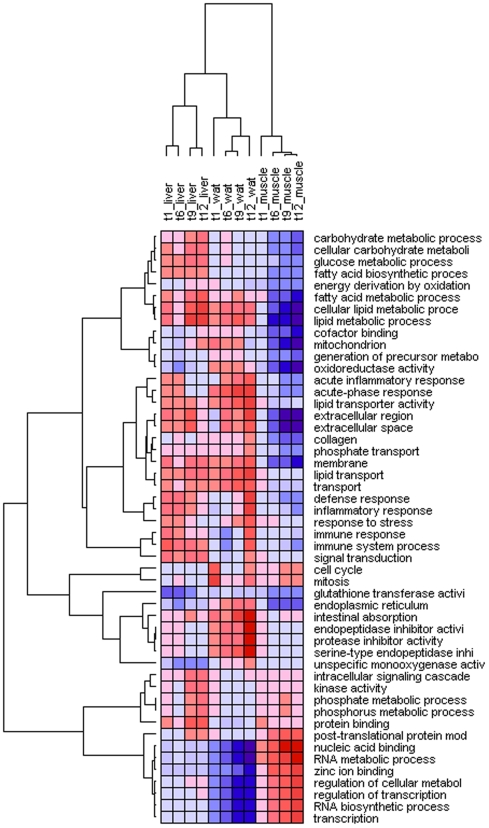
Time-resolved pathway analysis for liver, WAT and muscle.Hierarchically clustered heat map of enriched functional groups of genes (Gene Ontology). Shown are functional groups of genes that are significantly enriched in at least one time point and tissue. Clustering analysis (Pearson correlation, complete linkage) was performed on average t-values for each time point. Red (blue) indicates up-regulation (down-regulation) of a functional group and a positive (negative) t-value. The color intensity reflects the magnitude of a change. Columns represent the different tissues over time and rows represent the functional clusters.